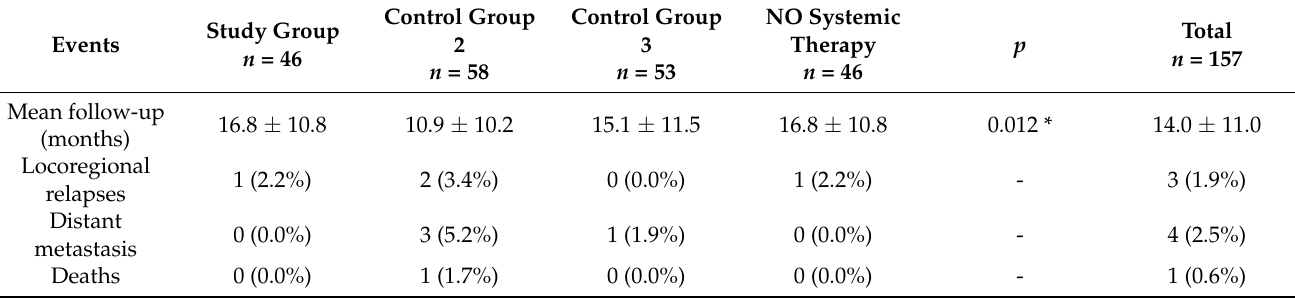
Table 5. Events during